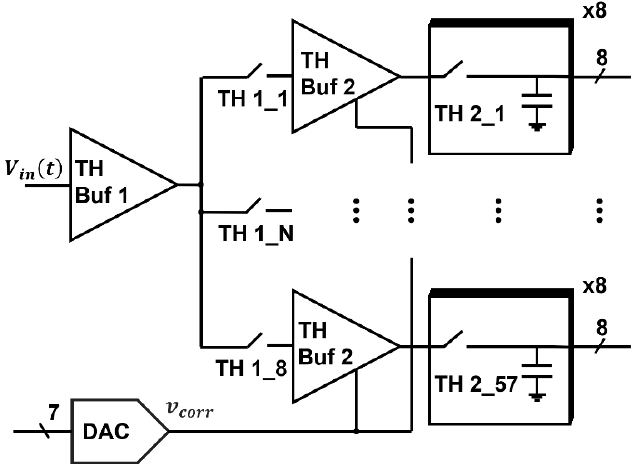
Figure 2. An 8 × 8 time-interleaved two-stage track-and-hold circuit and DAC for non-linearity calibration.